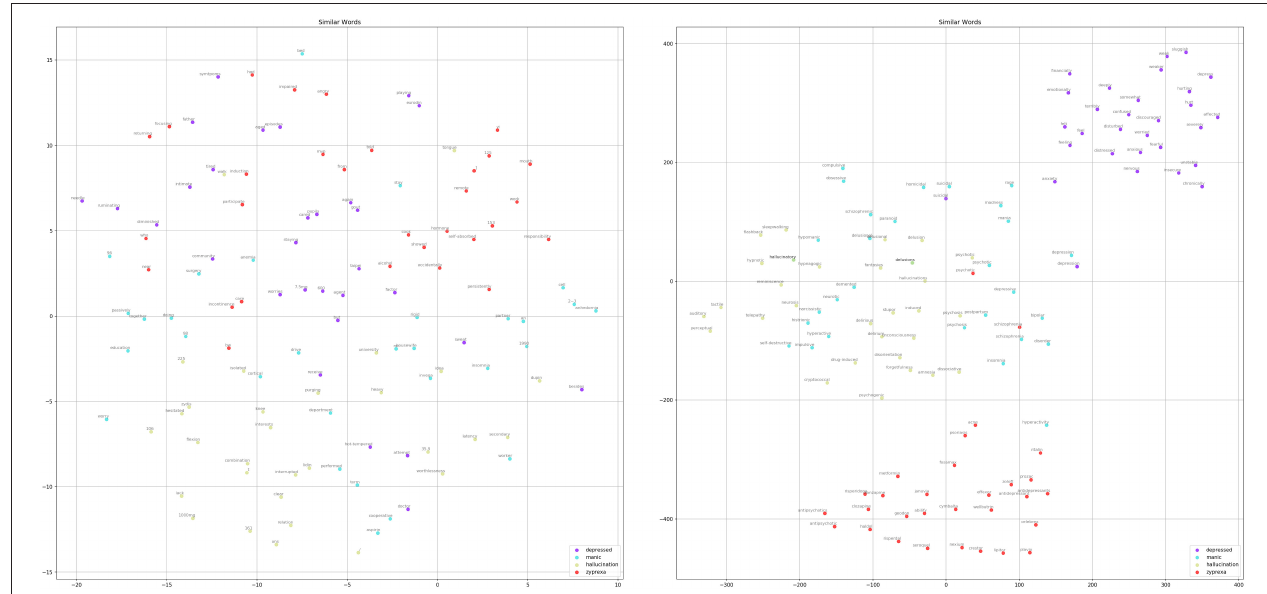
FIGURE 8 | Comparison of the top-30 similar words for “depressed,” “manic,” “hallucination,” and “zyprexa” regarding the randomly initialized embedding of HAN-rand (left) and the pre-trained word embedding of the HAN-glove model (right).